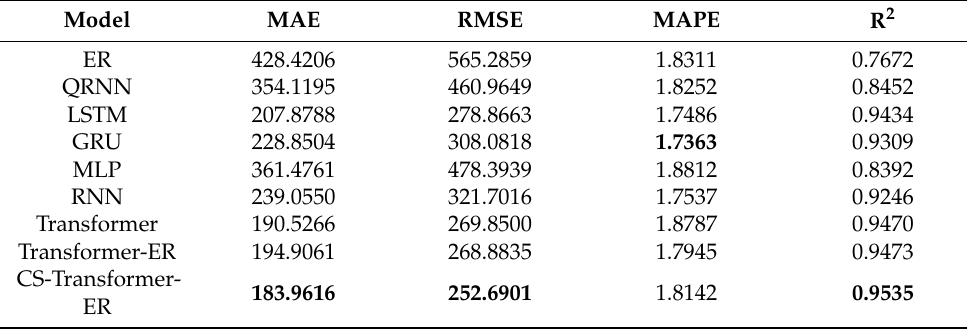
Table 2. Comparison of the point prediction results for all examined